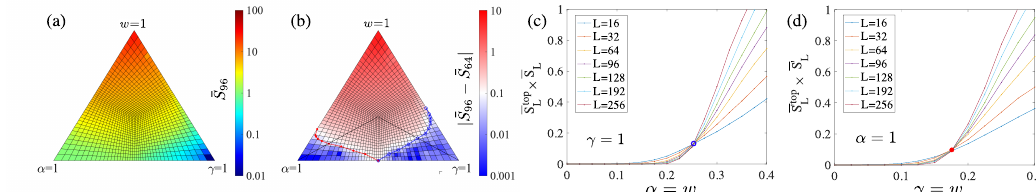
Figure 3: Phase diagram of full model (a) Density plot of ¯ S as a function of w , γ and L α ( w + γ + α = 1) in barycentric coordinates for L = 96. Area law scaling is recovered = 1 and ¯ S = 0 respectively, while w = 1 in the limits α = 1 and γ = 1 with ¯ S 96 96 − ¯ S displays volume-law scaling. (b) ¯ S . The entanglement entropy difference how 96 64 a sharp crossover between the three distinct phases. Transition points between the sub-volume-scaling and trivial area-law scaling (blue and red circles) and between the sub-volume-scaling and topological area-law scaling are determined by crossings × ¯ S × ¯ S ( c − fermion basis) for fixed γ = 1 (c) Data showing ¯ S top in the measure ¯ S top L L L L top × ¯ S ′ and α = w . (d) Data showing ¯ S ′ ( d -fermion basis) according to (13), for L L fixed α = 1 and γ = w . In the barycentric coordinates these two data sets fall along the dotted lines shown in panel